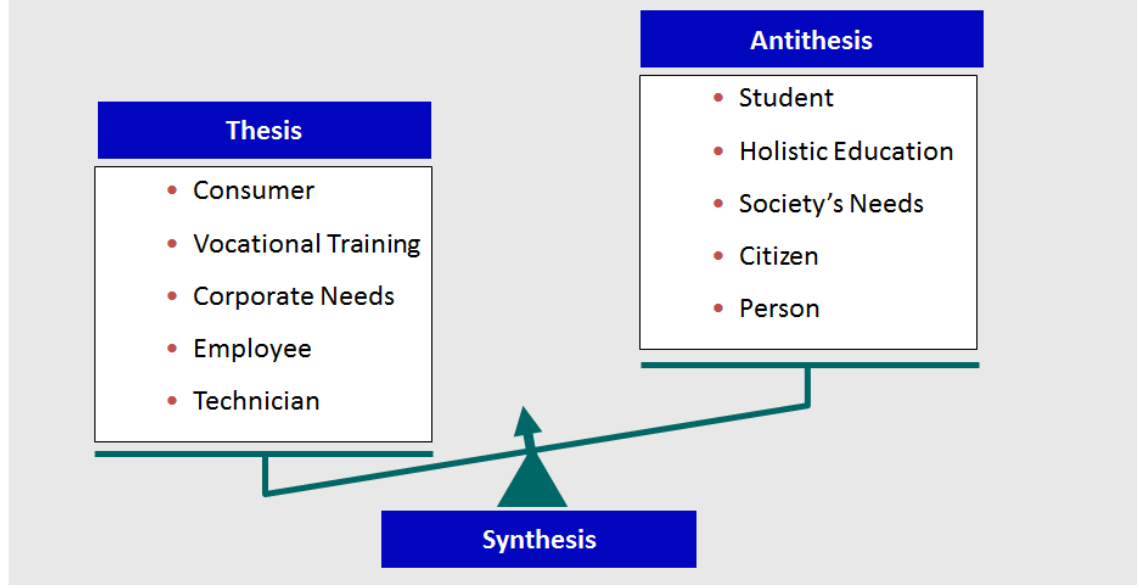
Figure 1: The student – A perpetually developing